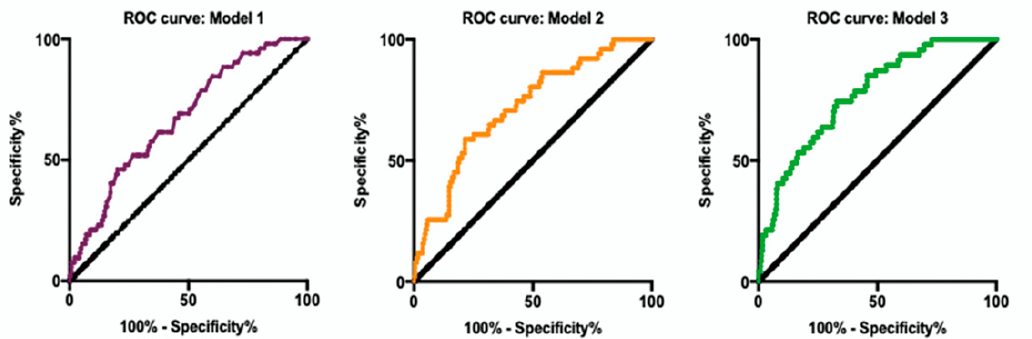
Figure 3. AUROC curve predicted by Model 1, 2, and 3.